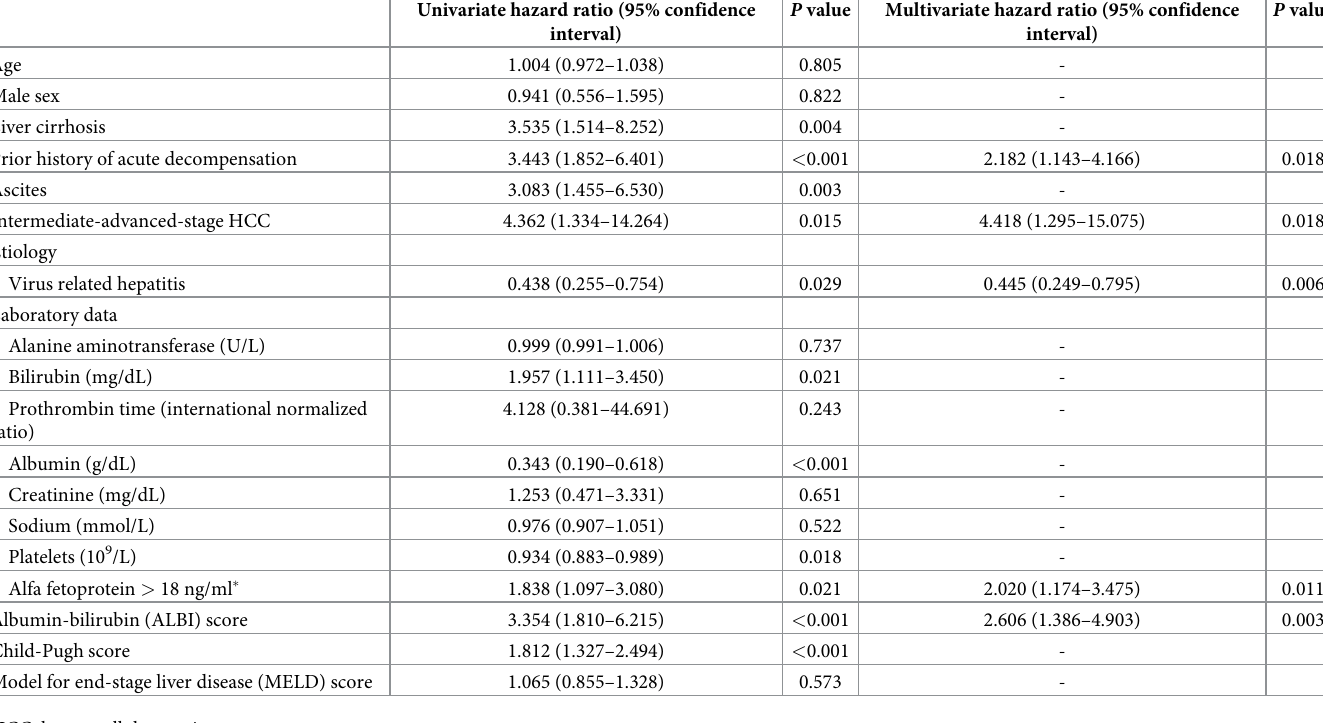
Table 4. Cox regression analyses of predictive factors for the development of acute decompensation in the ablation